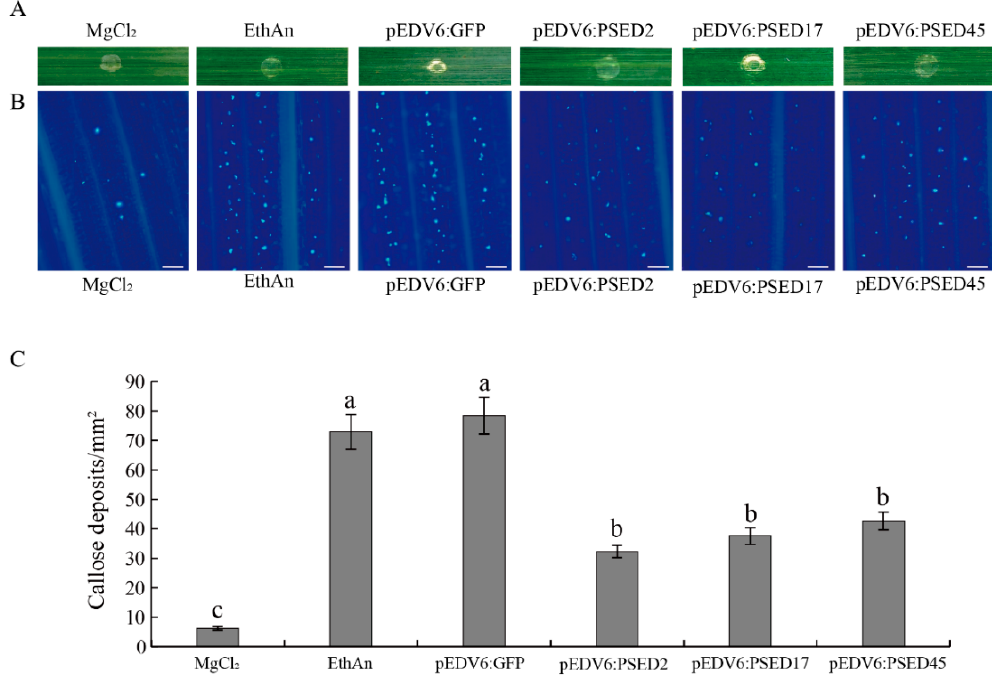
biological replicates with 20 unit areas per replicate ( ± SD). Different letters note significant differences among different treatments ( p < 0.05) following Duncan’s multiplication range